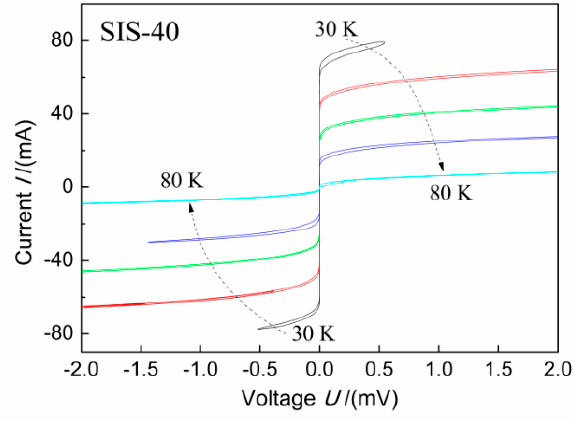
Figure 7. I–V curves of the YBCO/LAO (40 nm)/YBCO trilayer under different temperatures.